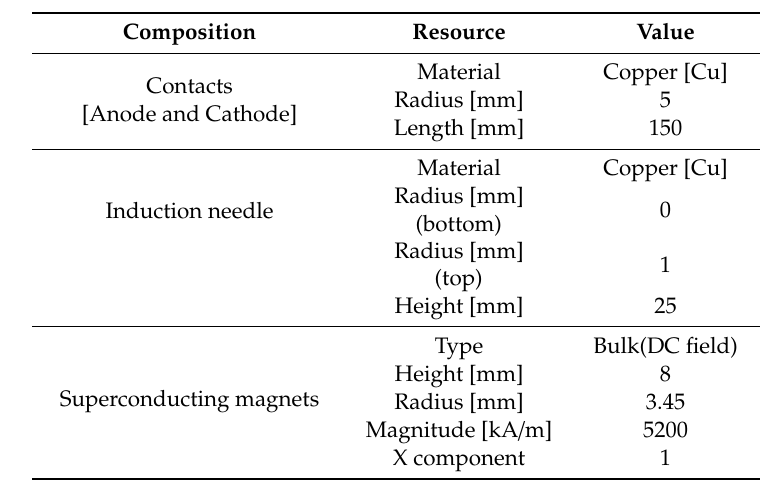
Table 1. Design parameters of simulation